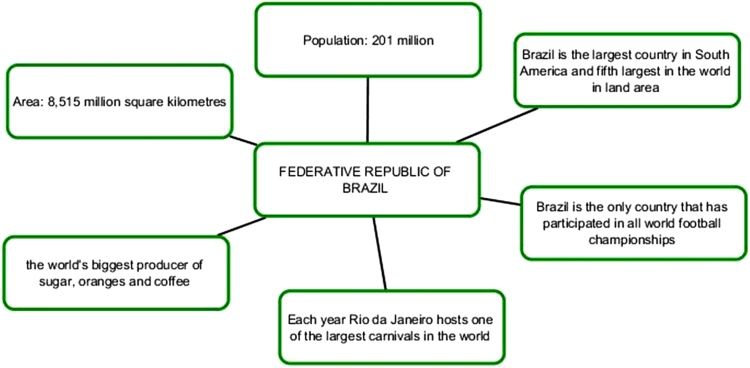
Infographics “Federative Republic of Brazil” [1].